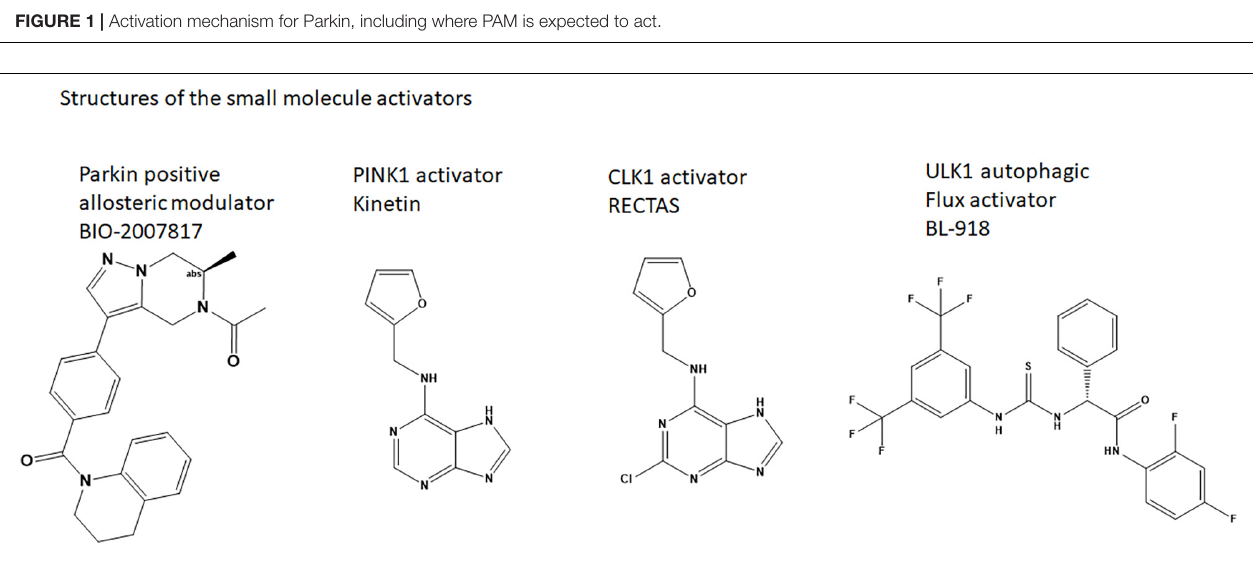
FIGURE 2 | Structures of the small molecule